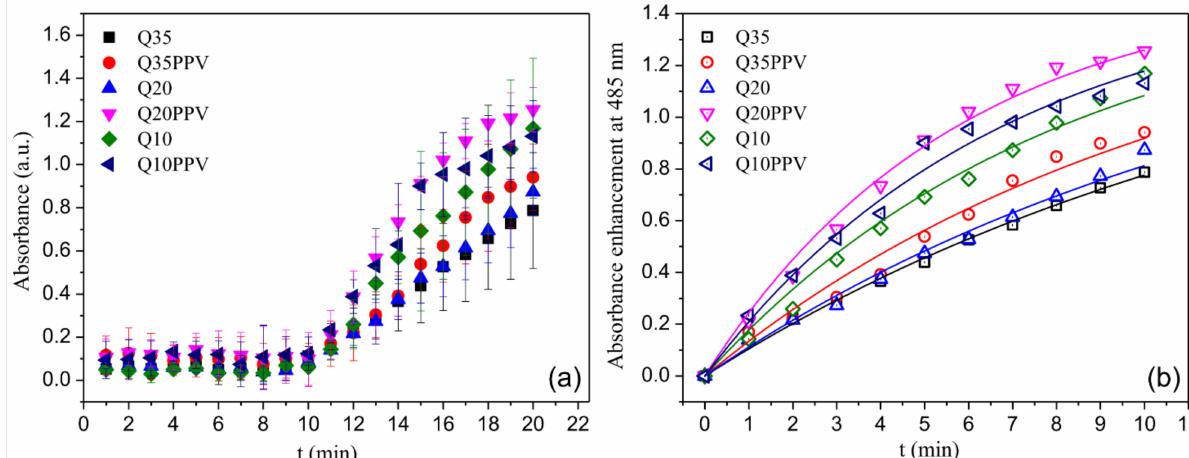
Figure 4. Absorbance profiles resulted from ROS production under blue-light irradiation during the whole analyzed interval as a function of time ( a ); 10 min range used for kinetic analyses ( b ). The solid lines presented in ( b ) were obtained fitting the data by using Equation (S5) shown in Section S.3 in the Supplementary